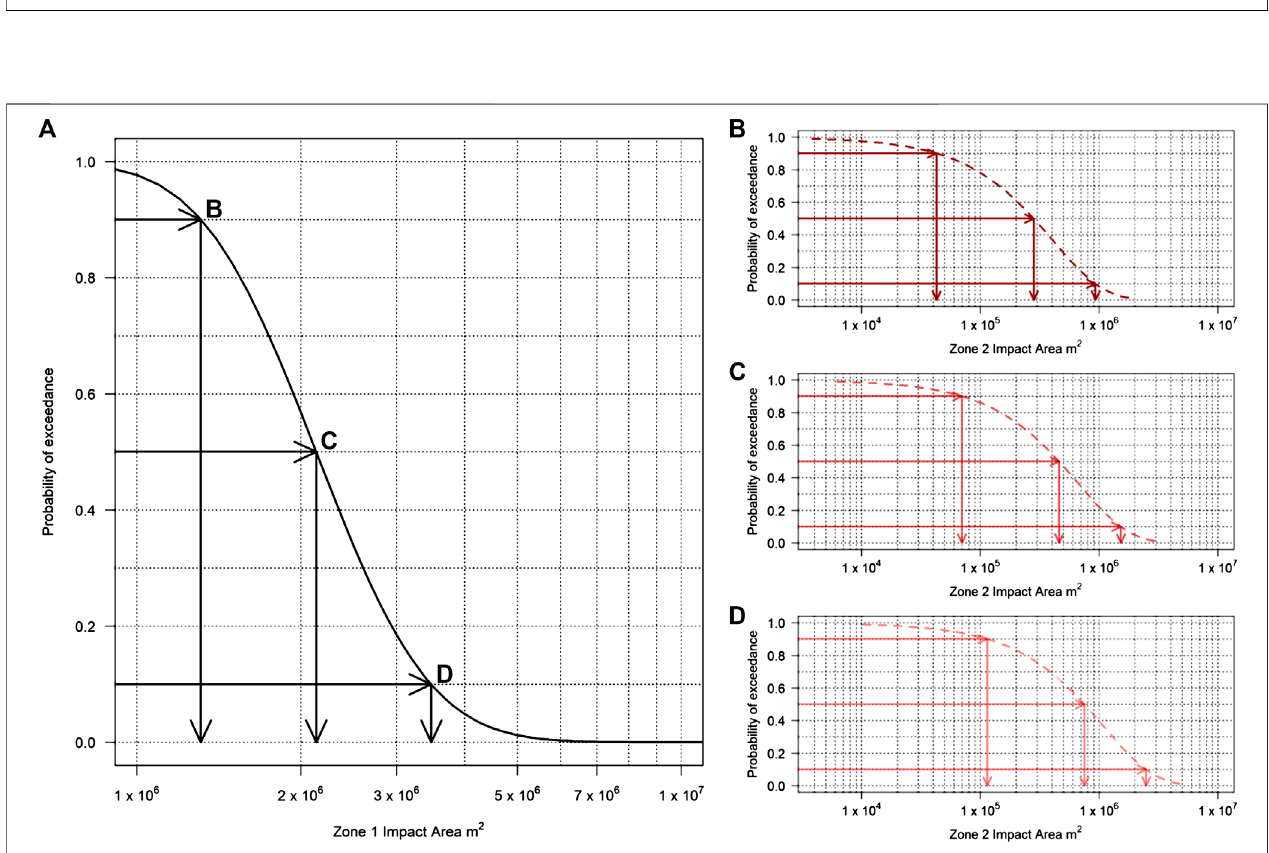
FIGURE 10 | Estimated probabilities of exceedance for a range of potential Zone 1 and Zone 2 impact areas for the hypothetical case, where points B, C, and D indicate representative Zone 1 impact areas for which Zone 2 impacts are estimated.